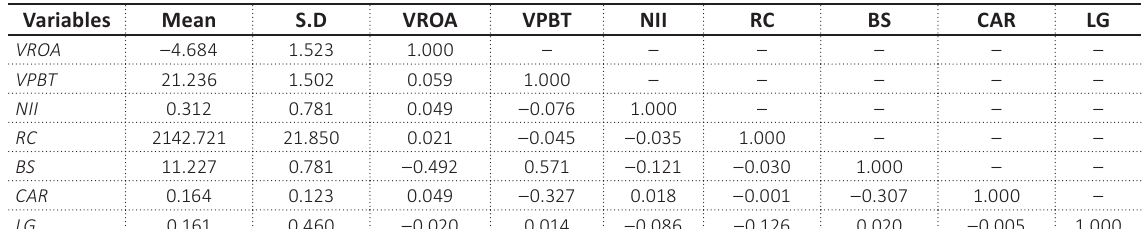
Table 2. Descriptive statistics and correlation